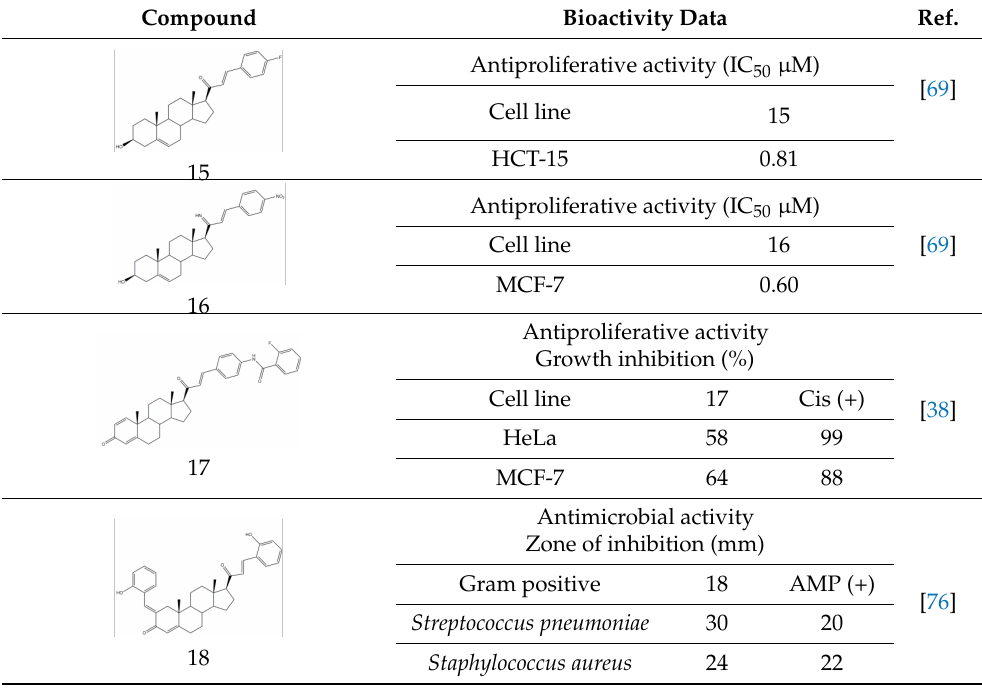
Table 2. The most active 21 E -arylidenepregnene derivatives. Positive controls, when shown, are identified by (+) symbol